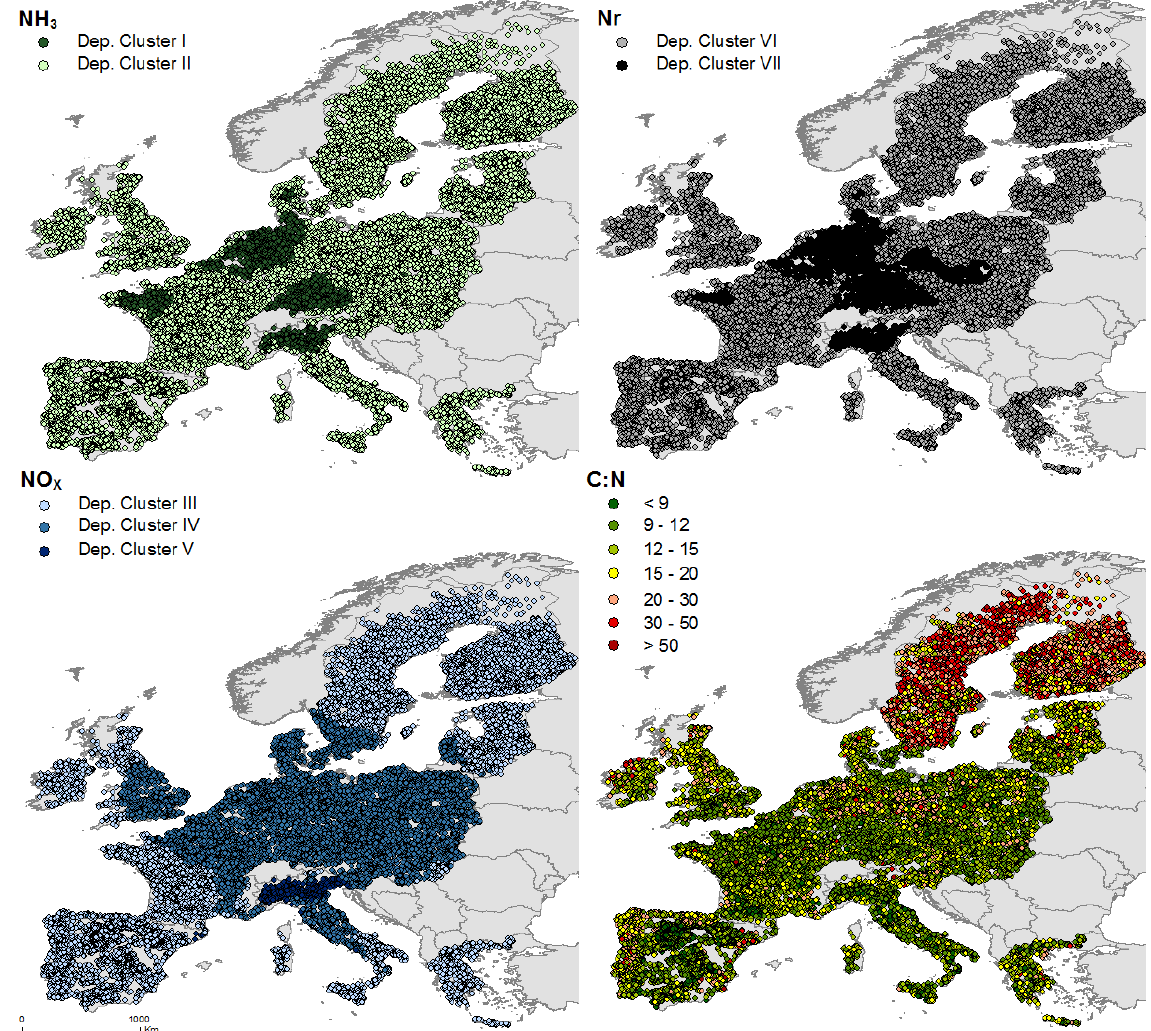
Figure 1. Nitrogen deposition and the recent soil C:N ratios (mass units). Spatial clusters (shown clockwise) of NO x , NH 3 and Nr (NO x and NH 3 ) 1880–2010 depositions at the 19458 sites of the soil C:N in 2009. The darker the colour of a cluster, the higher the nitrogen load for NH 3 , NO x and Nr. Deposition Cluster IV reveals a high degree of homogeneity in NO x deposition, in contrast to the patchiness of Deposition Cluster I (NH 3 ) . However, NH 3 deposition accounts the most for the aggregation of Deposition Cluster VII